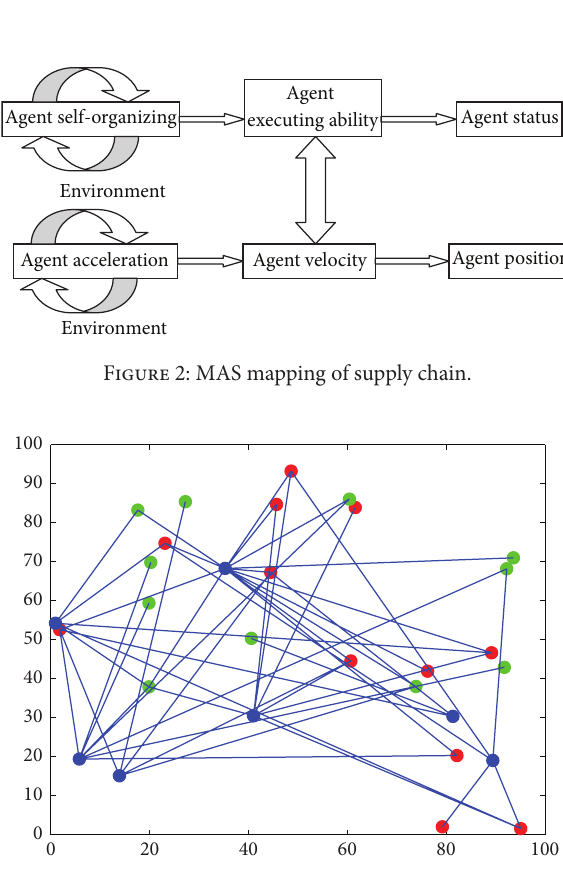
ability and executing ability of each member in the